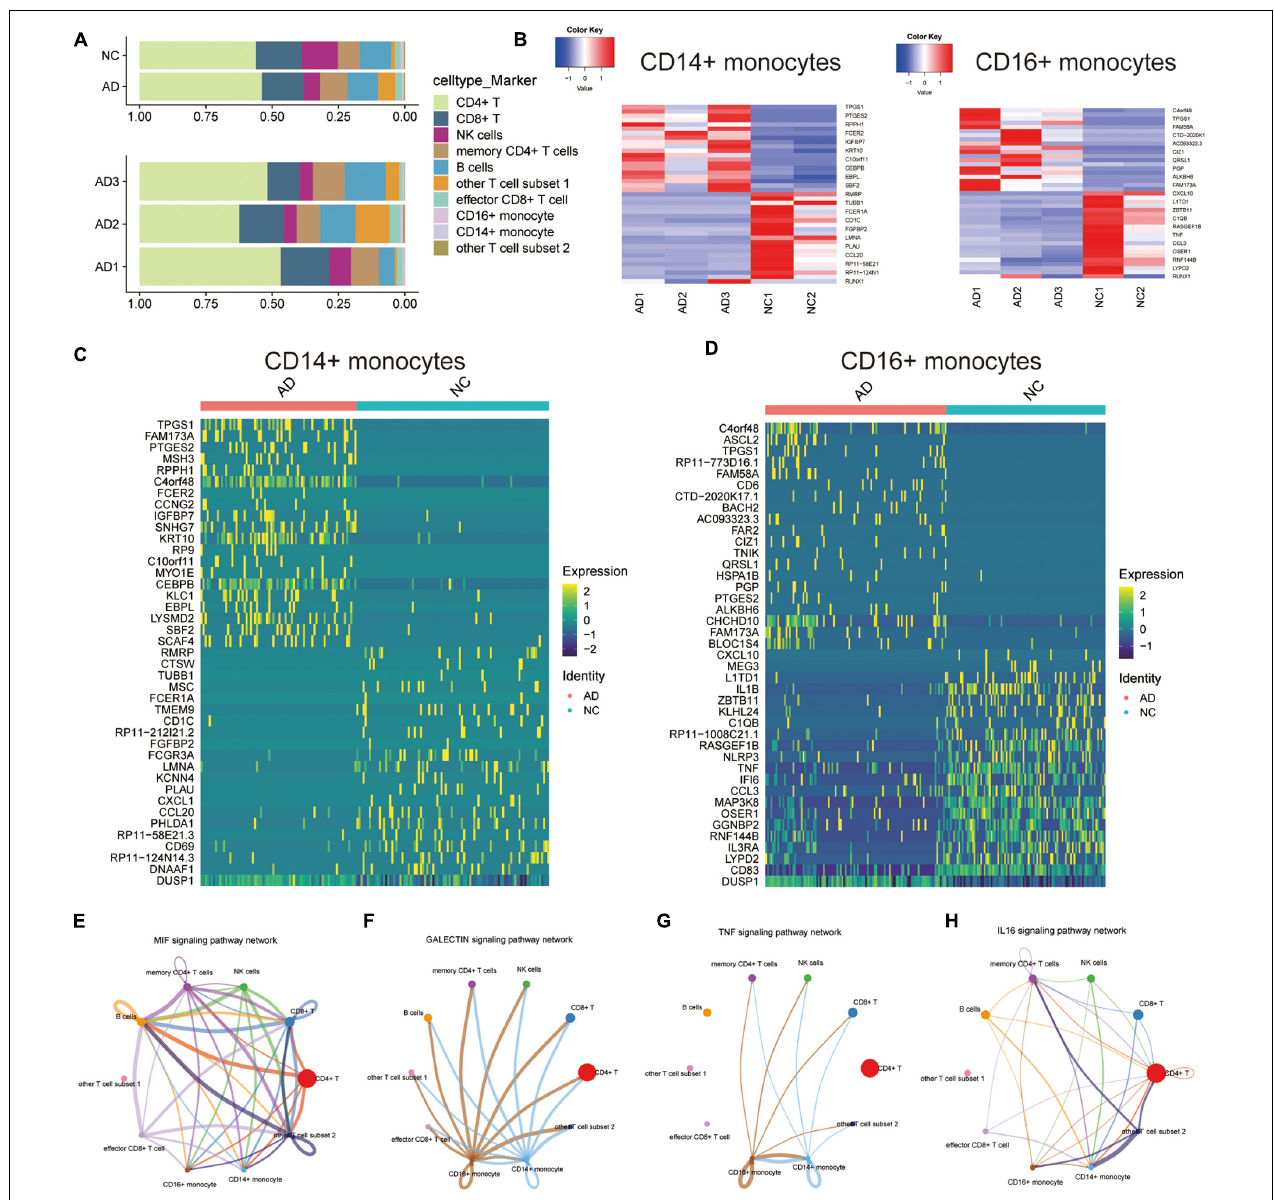
FIGURE 2 | Differential expression and cellular communication characteristics of CD14 + and CD16 + monocytes in patients with AD. (A) Horizontal bars show the proportion of each cell type in different patients; (B) Deseq2 obtained the main DEGs in CD14 + and CD16 + monocytes; (C,D) Major DEGs in CD14 + and CD16 + monocytes obtained by APP lying the “FindVariableFeatures” function; (E–H) Cellchat-based results showing the association of specific cell populations with other cell populations in different key cellular pathways: MIF signaling pathway (E) , GALECTIN signaling pathway (F) , TNF signaling pathway (G) , IL16 signaling pathway (H)